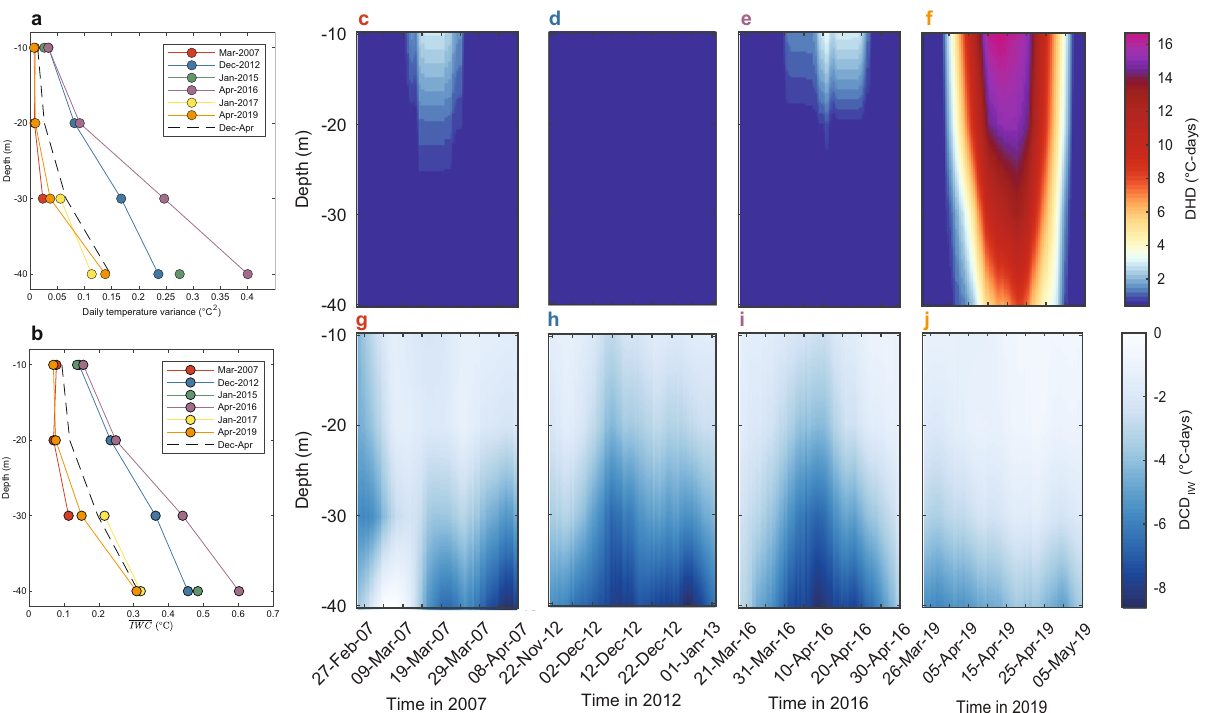
Fig.5|Comparisonofinternal-wavecooling(IWC)acrossdepthsduringrecent surface marine heatwaves (MHWs) around Moorea. Based on average a daily temperature variance (in °C 2 ) and b IWC (IWC in °C) during the six recent local MHWs(seeTableS4fordates)thatcanbegroupedinto:(1)highIWCeventsduring 2012(blue),2015(green)and2016(purple);and,(2)lowIWCeventsthatcoincided with bleaching events in 2007 (red) and 2019 (orange), along with early 2017